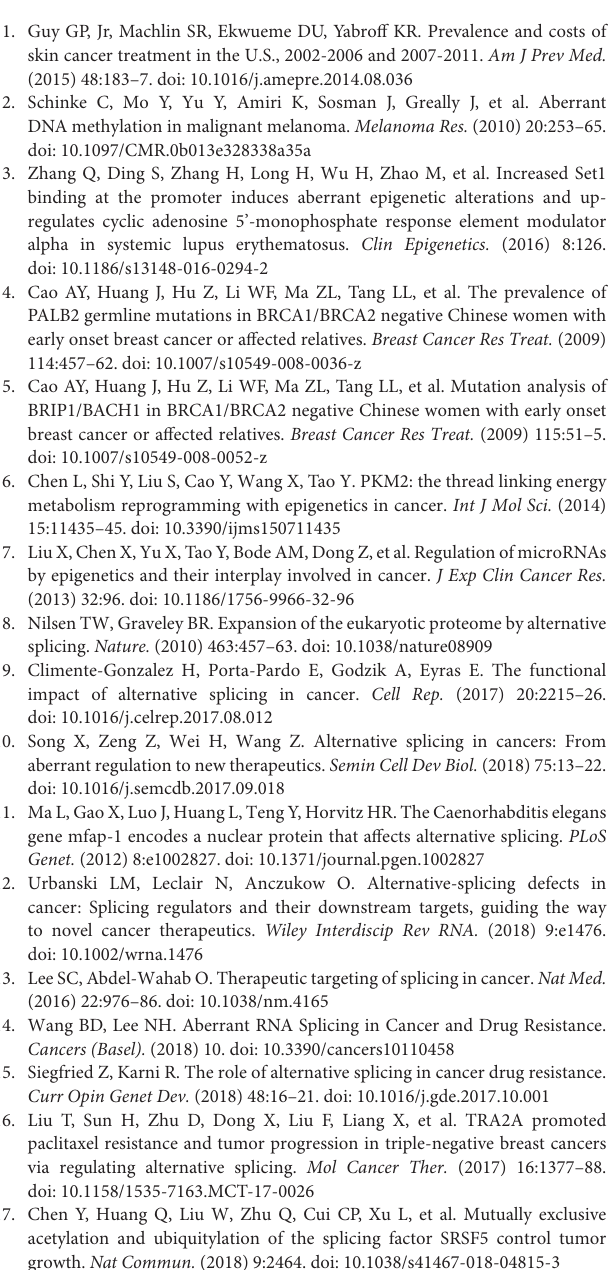
Supplementary Table 6 | Survival-related splicing events selected by Lasso regression. Among the 19748 splicing events affected by RBP mutations, a total of 919 splicing events were identified to be correlated with the overall survival of SKCM patients using Lasso regression. The Z_score (Cor), hazard ratio (HR), 95% confidence interval (95%CI_L and 95%CI_H, respectively) and p -value were listed